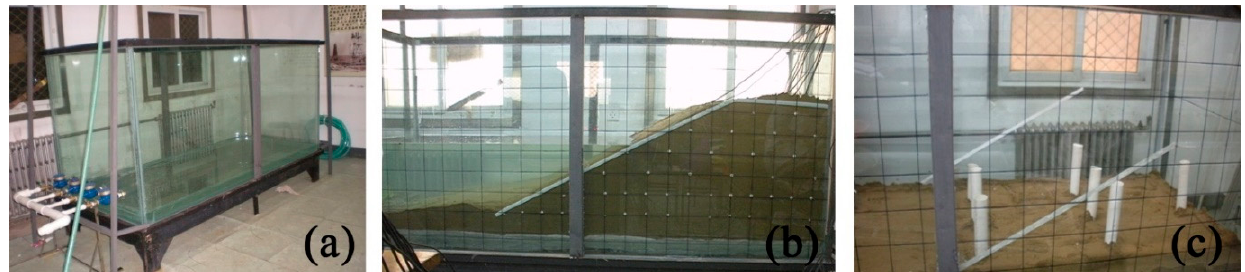
Figure 2. The layout of the model box and marking points: ( a ) model box; ( b ) mark point arrangement; ( c ) instrument burial.